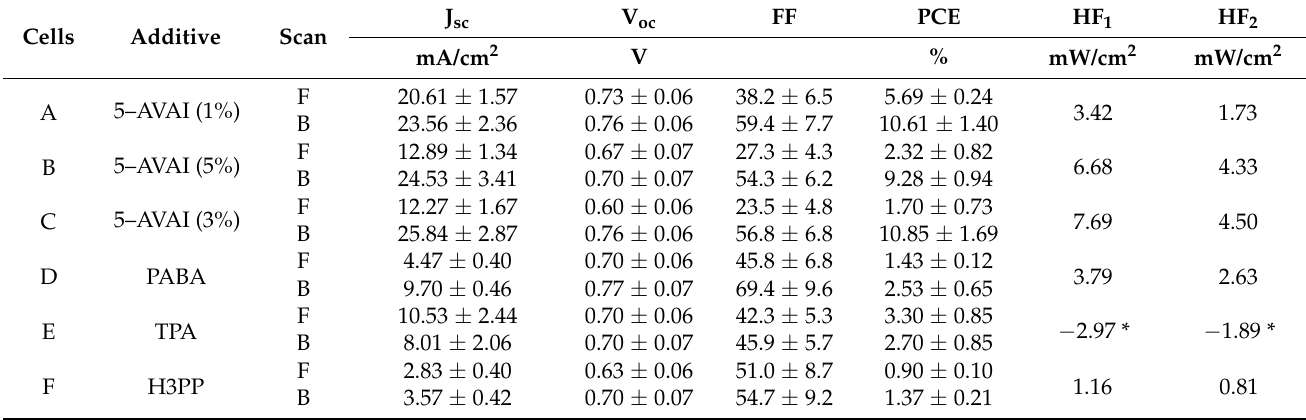
Table 1. Electrical parameters of the perovskite solar cells calculated as an average of 24 cells of each group (* this cell presented reversed hysteresis when compared to the other cells). Scan column indicates forward (F) or backwards (reverse, B) sweep of voltage during the J–V measurement. HF 1 and HF 2 are the hysteresis factors, as defined in Section